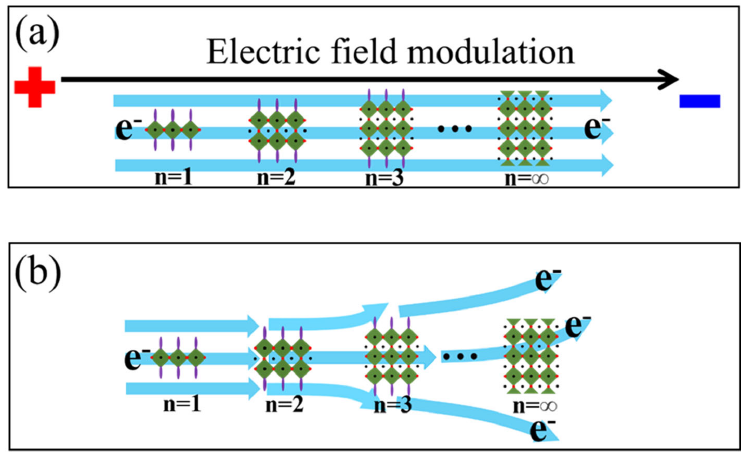
Figure 3. Schematic of ( a ) fast charge transfer channel between quantum wells through external electric field modulation in quasi-2D perovskite solar cells. ( b ) Inefficient random charge transfer in quasi-2D perovskite solar cells.